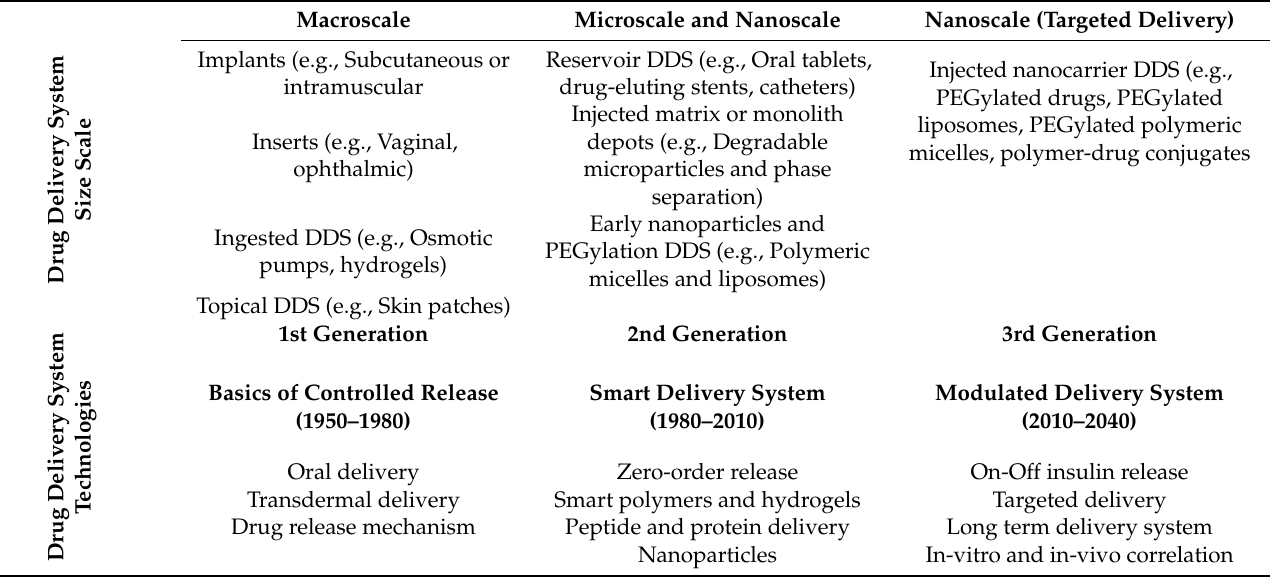
Table 7. Evolution of Drug Delivery Systems from 1950 to